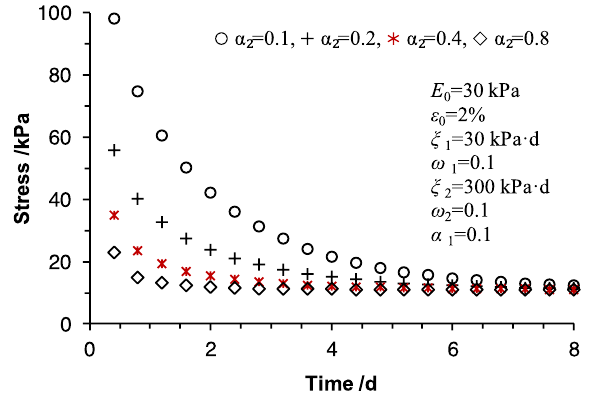
Figure 10. Sensitivity analysis of fractional-order α 2